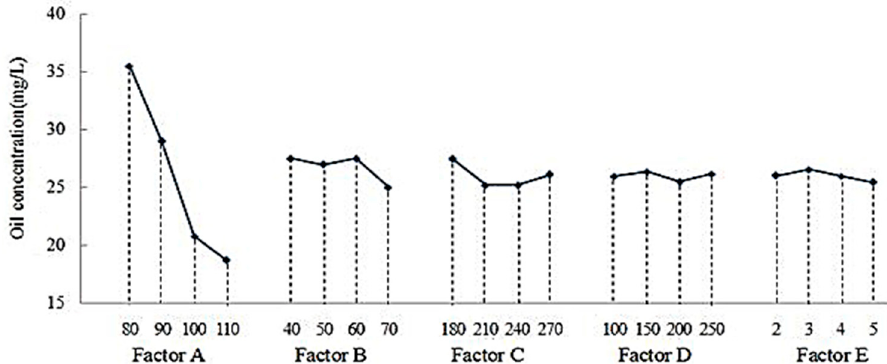
Figure 10. Relationship between the five factors and oil concentration.